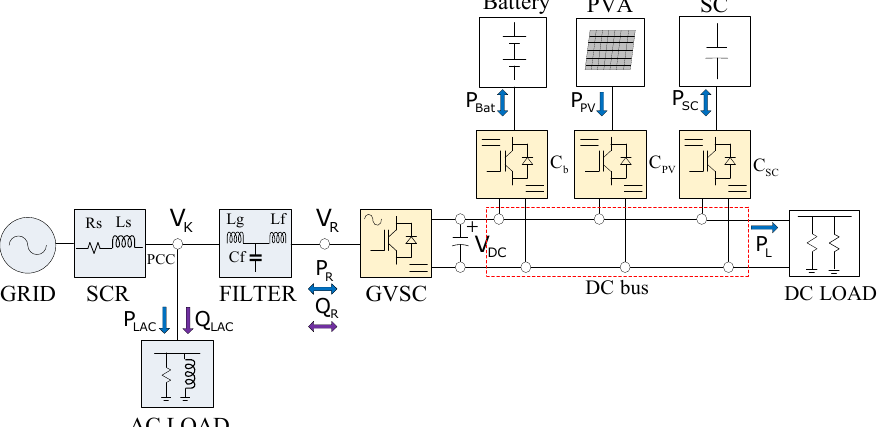
Figure 1. DCMG system configuration.